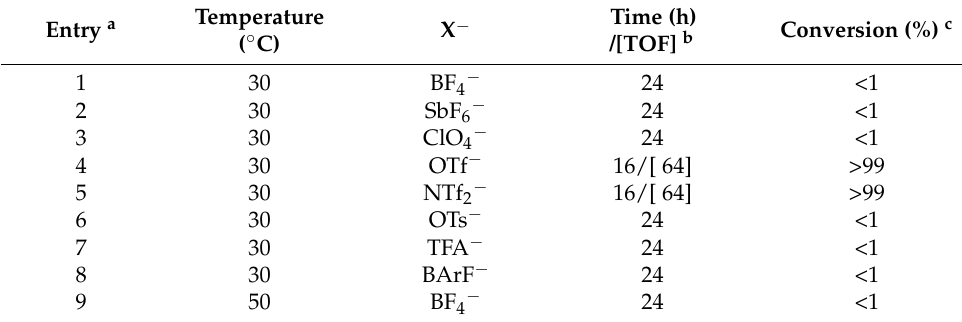
Table 18. Hydration of 3-hexyne catalyzed by (IPr)Au-X complexes.